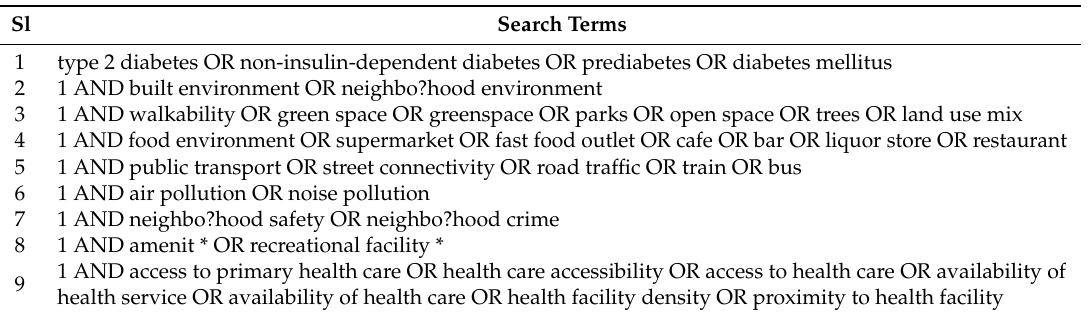
Table 1. Terms used to search relevant